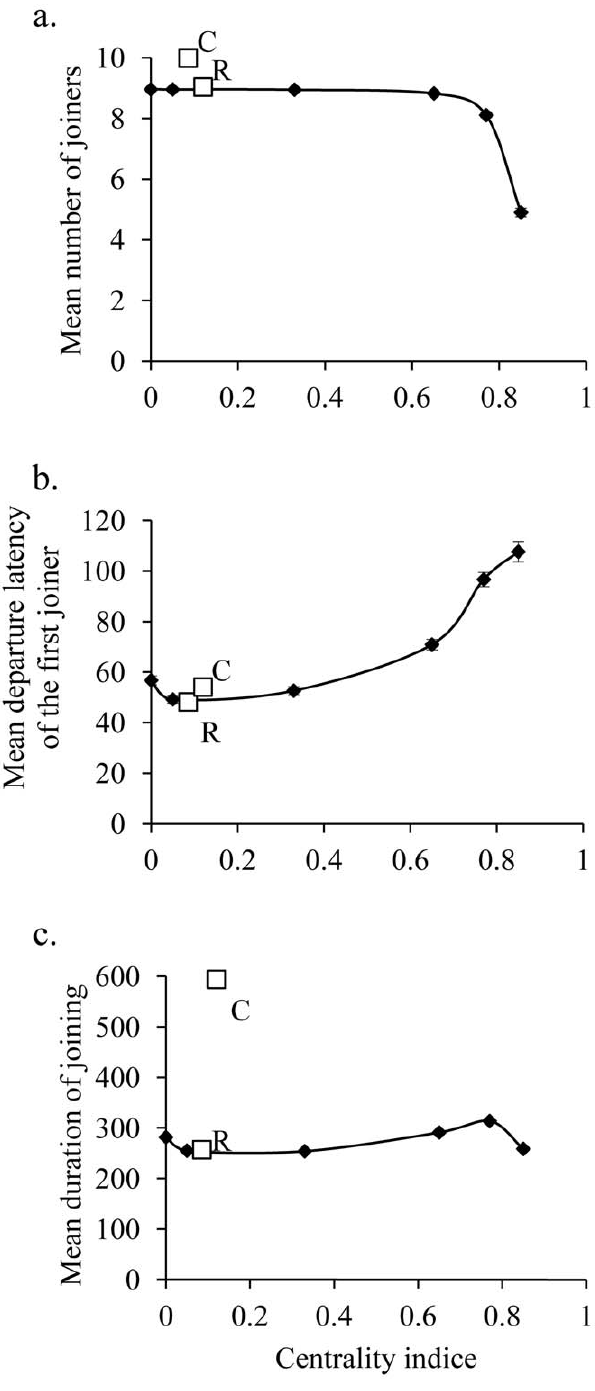
Figure 2. Relation between the centrality index and variables of collective decisions (movements). (a) Mean number of joiners, (b) mean departure latency of the first joiner, and (c) mean duration of joining whatever the initiator’s identity. The relation between the centrality index and the mean duration of joiners follows an exponential law. The relation between the centrality index and the mean departure latency of the first joiner does not follow any tested law. The relation between the centrality index and the mean duration of joining follows an exponential law. Parameters of functions are given in the global analyses section of Results. For each network, error bars are indicated and represent the standard error. R indicates the result for random network and C indicates the result for chain